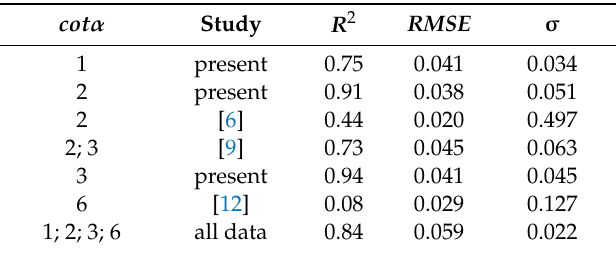
Table 4. Goodness of fit ( R 2 ), root mean square error ( RMSE ) and standard deviation ( σ ) for data given in Figure 3 according to Equation (4). cot α Study R 2 RMSE σ present